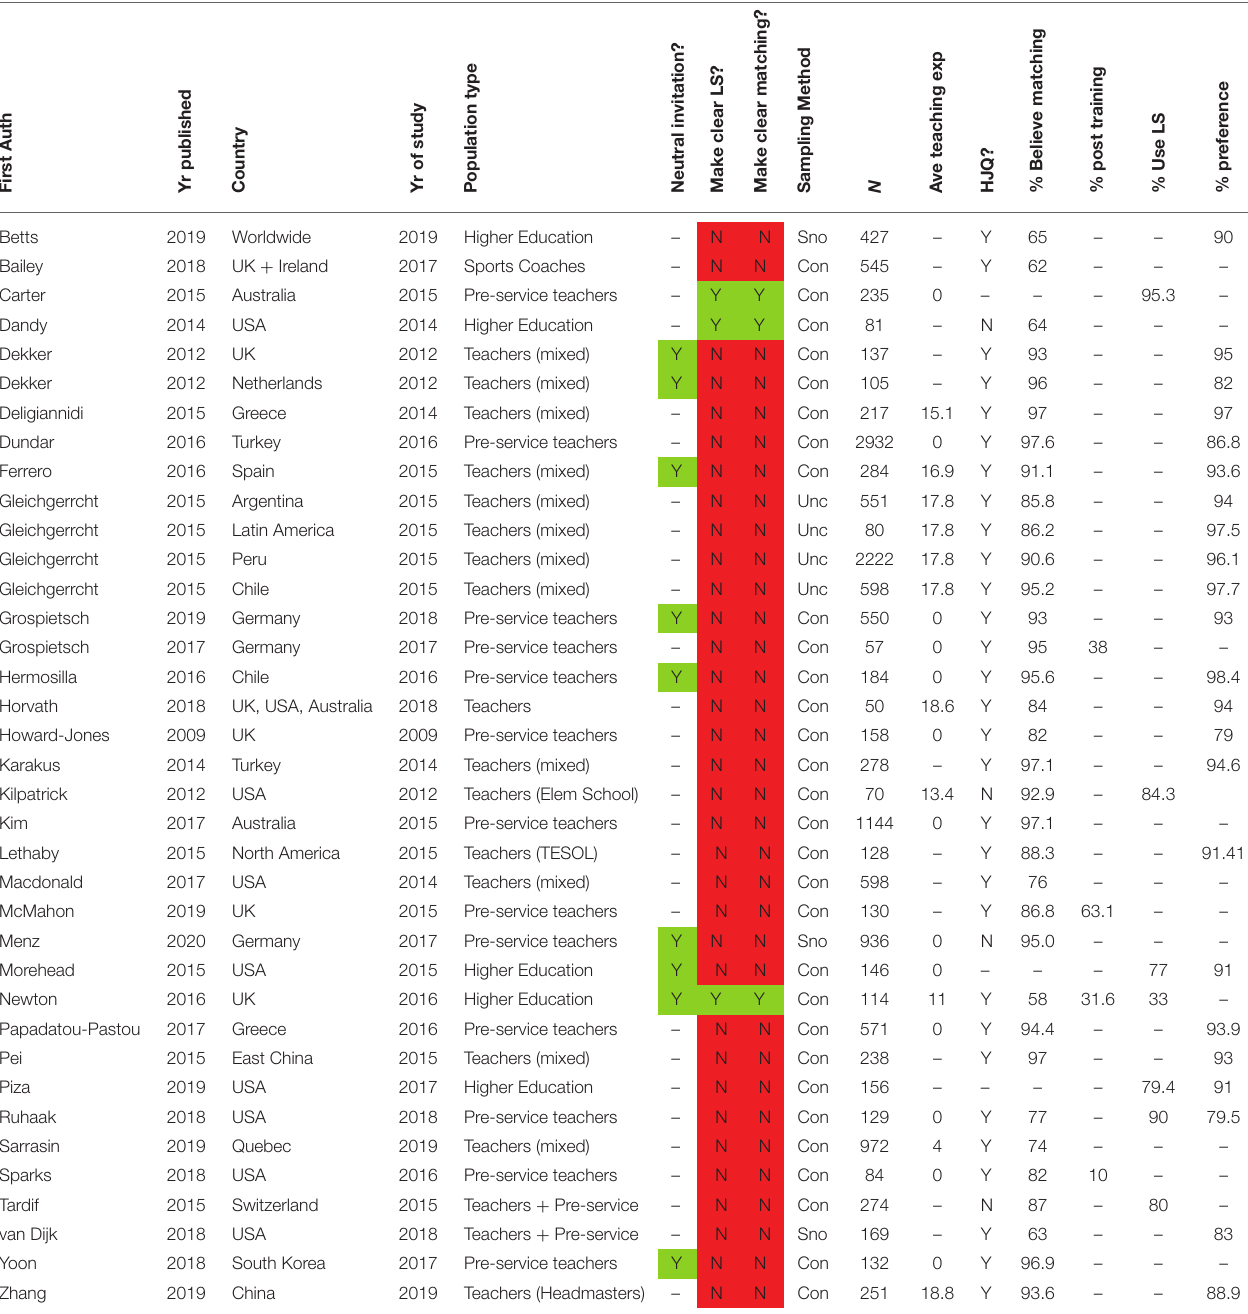
TABLE 1 | Characteristics of included